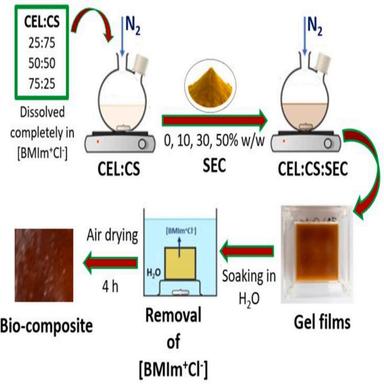
Schematic diagram showing CEL:CS and CEL:CS:SEC composites synthesis.